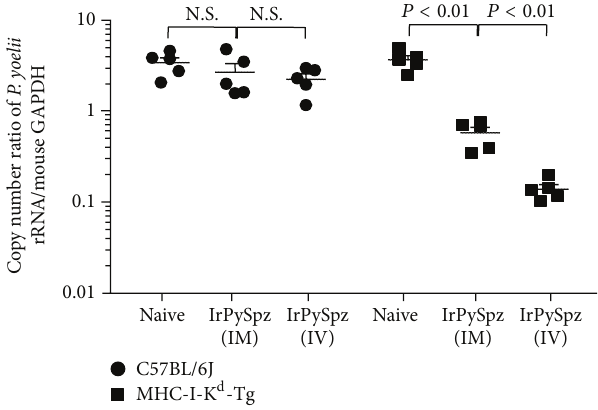
Figure 2: Protection against malaria infection after a single immu- nizing dose of IrPySpz . Groups of naive B6 mice and MHC-I-K d - Tg mice (5 per group) were immunized with 1 × 10 5 IrPySpz via IV or IM injection. Protection assay was performed by challenge with 5 × 10 4 viable P. yoelii sporozoites via IV injection 2 weeks after immunization. Na¨ıve B6 mice and MHC-I-K d -Tg mice were also challenged as infection control. Parasite burden was described as a ratio of the absolute copy number of parasite-specific 18s rRNA to that of mouse GAPDH. 𝑃 < 0.01 is considered statistically significant, whereas N.S. means “not significant” in Figures 2–4.